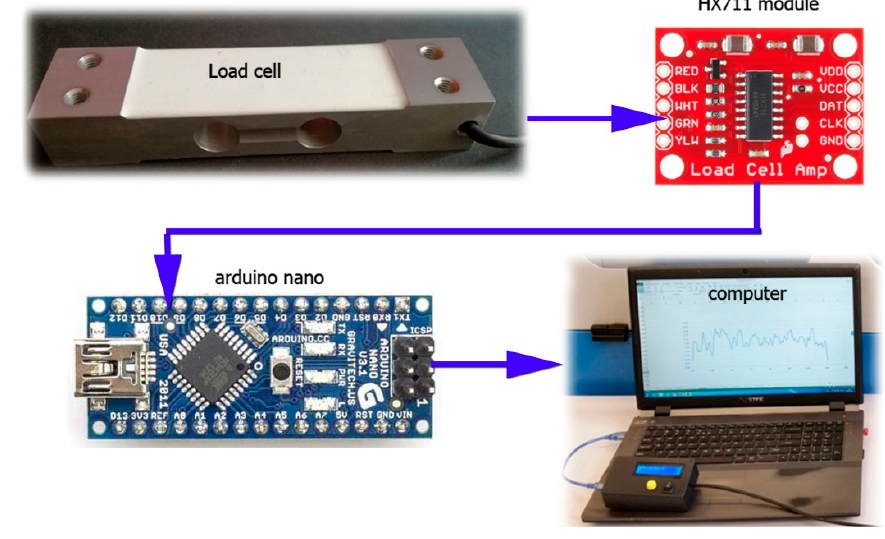
Figure 5. View of the dynamometer components